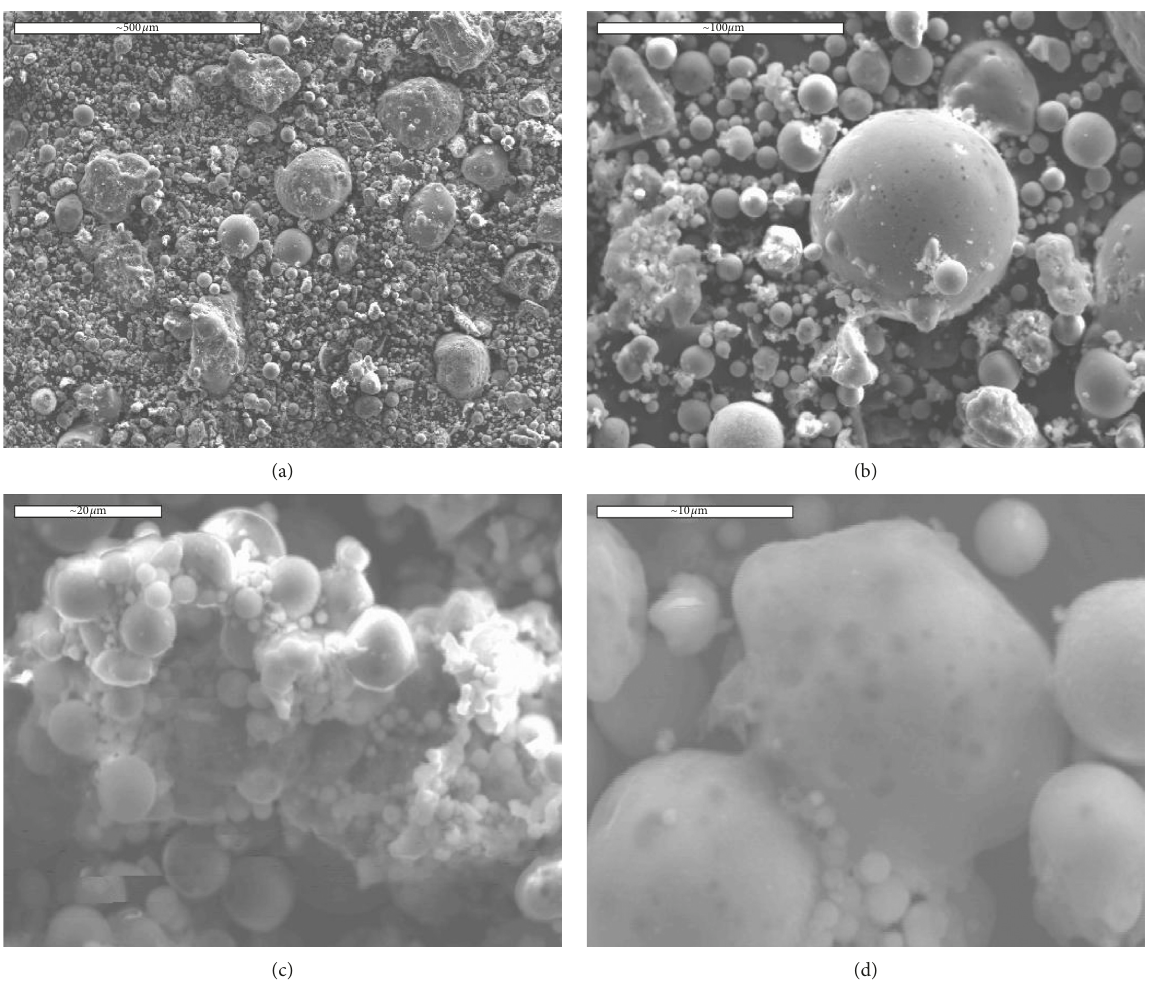
Figure 4: Microstructure of fly ash. (a) Precision of 500 μ m. (b) Precision of 100 μ m. (c) Precision of 20 μ m. (d) Precision of 10 μ